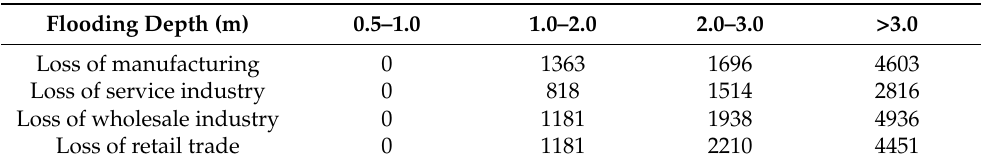
Table 2. Direct flood loss assessment equations in various categories of industry and commerce for Tainan City (NT$/m 2